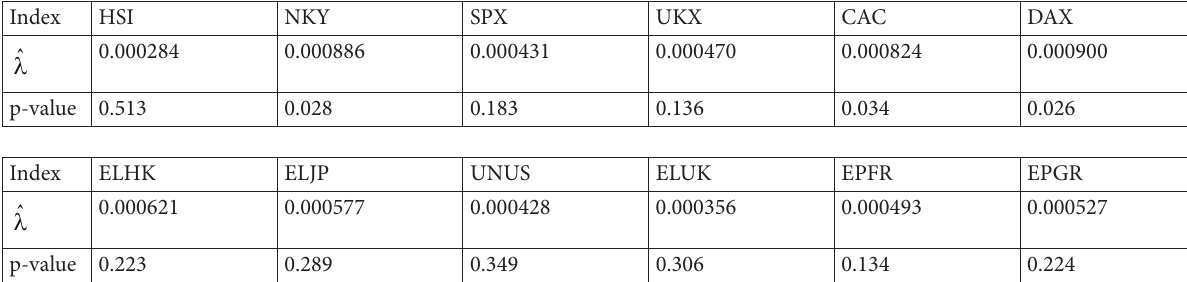
Table 9. The test results for the Halloween effect using the normal method